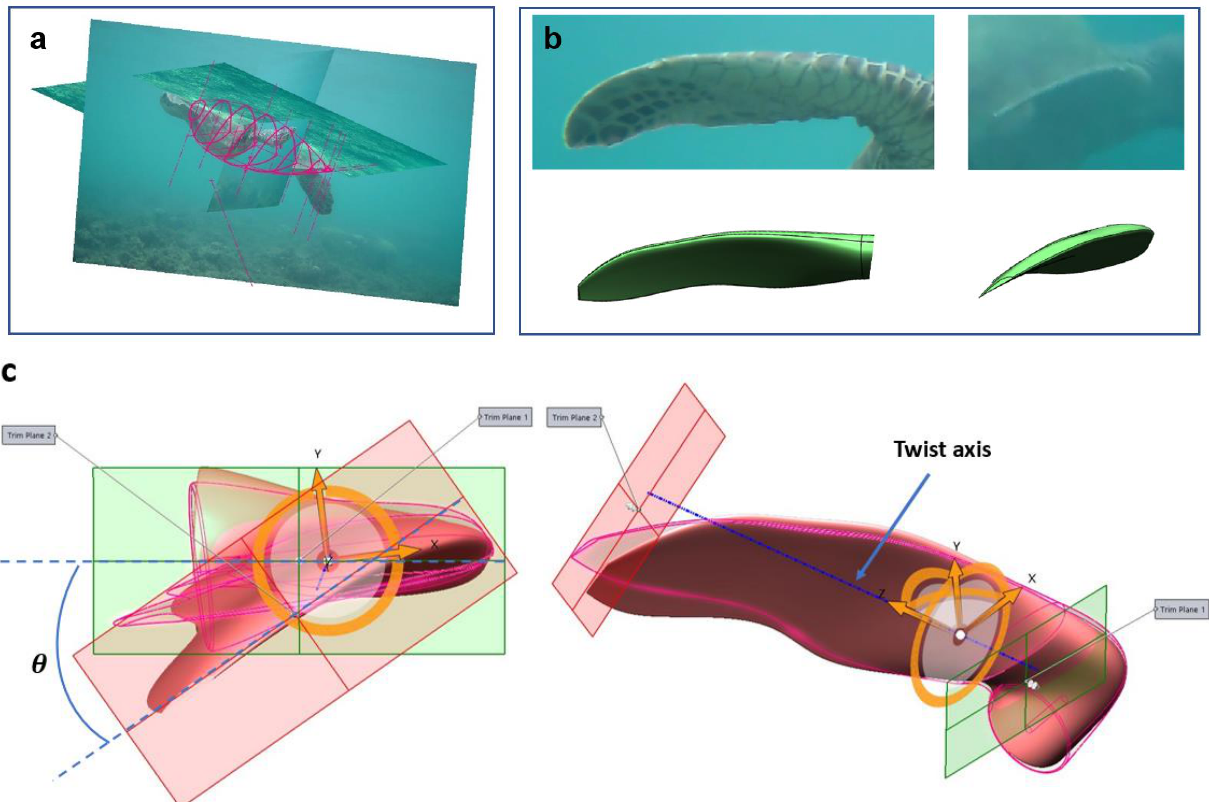
Figure 3. Turtle geometry development. ( a ) Side, top and front view footage sets of wild green sea turtles ( Chelonia mydas ) overlayed in CAD, showing the two-dimensional sketches on each generated plane. ( b ) Images from van der Geest et al. [16] showing wing twist compared with CAD models during the upstroke. ( c ) Wing twist generation in CAD using the SolidWorks feature “Flex” to generate a linear varying twist between the plane at the wing tip (red plane) and elbow (green plane).